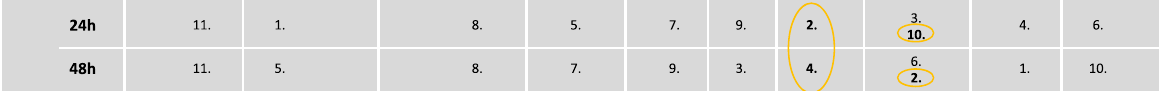
Figure 4. DDB2 results. Display of TaqMan assay arrangement on a schematic image of DDB2 (note: size ratio of exons to each other is not accurate), baselines and differential gene expression after 0.5 Gy and 4 Gy after 24 h and 48 h. At the bottom of the figure, the inter-individual variability is shown. The assay with the lowest sum of the standard deviation of the FCs over all dose categories is ranked 1st. Correspondingly the assay with the highest sum is ranked last. Starting with the baseline and working downwards, the assays meeting the criteria defined in the material and methods are circled. For illustration, the inter-individual variability of the TaqMan assays identified using the other criteria (baseline, dose dependency, time persistency) are circled in orange. The two encircled assays on the schematic image of DDB2 are the ones most suitable for biodosimetry purposes. Asterisks mark the best coverage assay. Assay labels starting with the two capital letters “AR” can be found after creating an account at Thermo Fisher web site, entering the “Reorder Custom Assays” section with the implemented search function in the “Custom TaqMan Assay Design